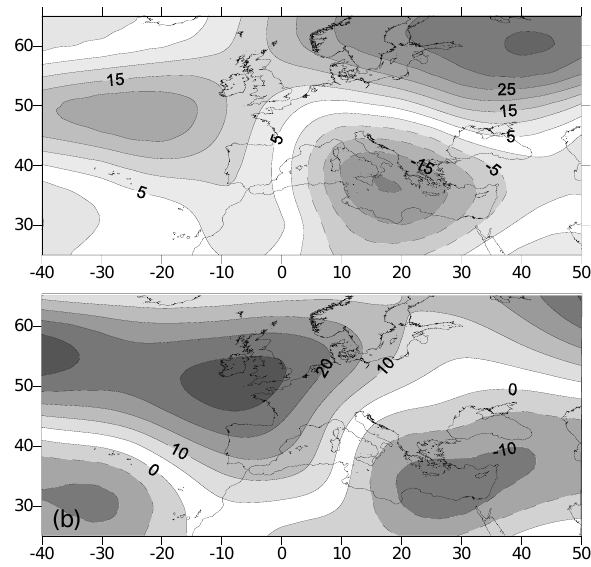
Fig. 3. Composite anomalies of 500hPa geopotential heights for the winters of extreme daily precipitation intensity a) for the present climate (control run) and b) for the future climate (B2a scenario); Dashed contours indicate negative values; Contour interval is 5gpm.